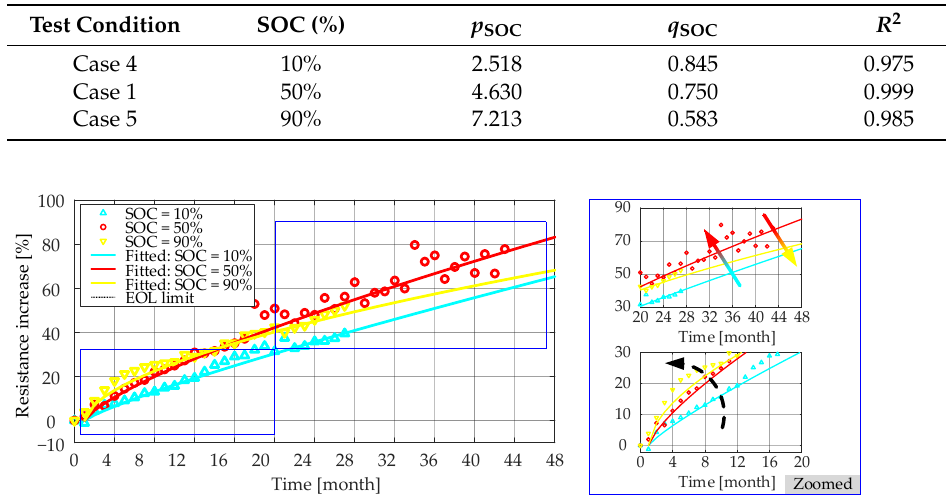
Figure 17. Effect of storage time and SOC level on the increase of the resistance (at 55 °C). Table 6. The curve fitting coefficients of the resistance increase model considering SOC level variation (temperature is fixed to 55 °C).